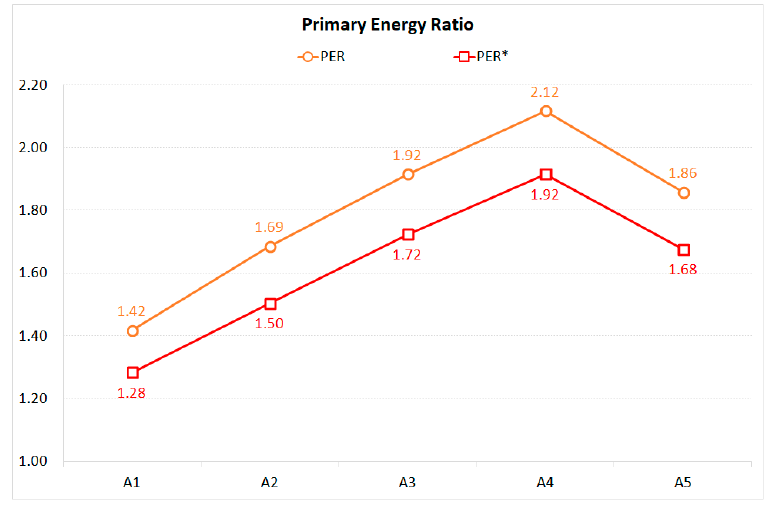
Figure 16. PER and electricity consumption by the circulation pumps (PER*) for the different alternatives.